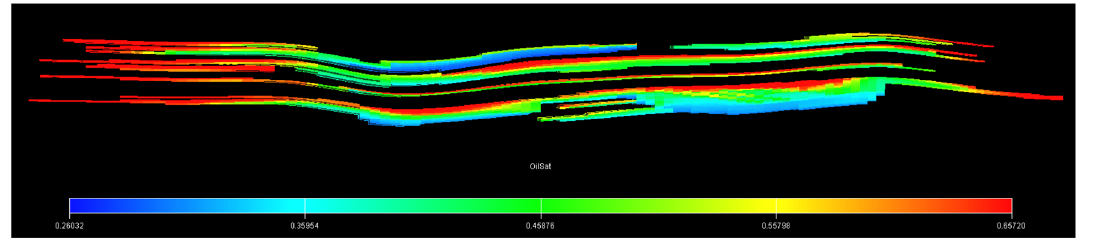
Fig. 14 The simulation result of profile A in the study area Table 3 The recovery percentage of different facies in the study area Model Facies